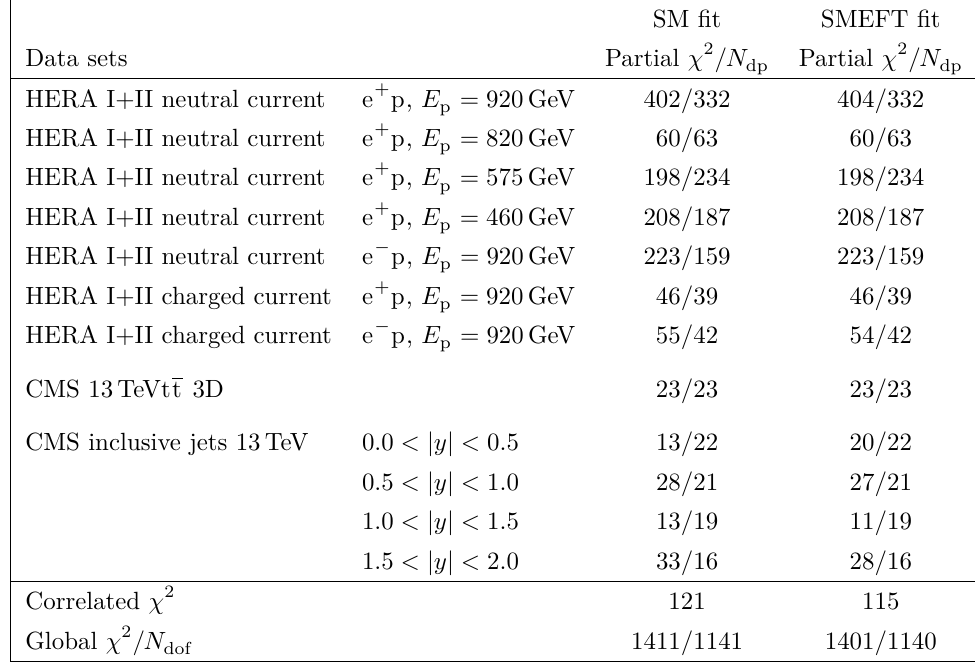
and the global χ 2 per degree of freedom, N , dp dof √ s = 13 TeV, obtained in SM